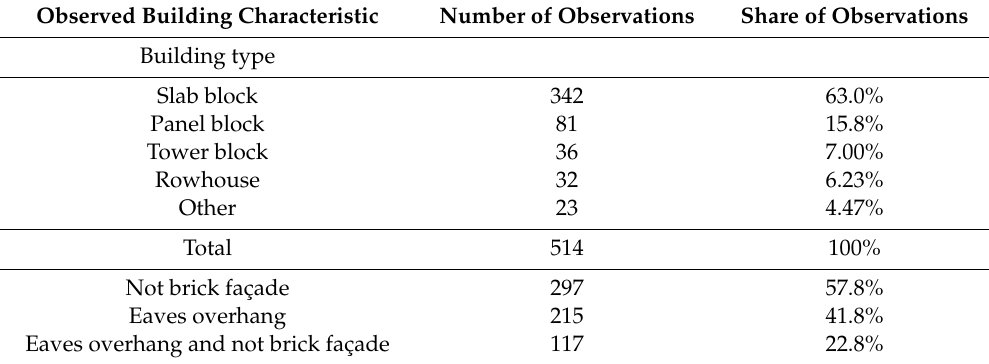
Figure 3. Example of observation in Google Street View of a building with eaves overhang and without brick façade, i.e., a building that is suitable for additional façade insulation. Table 5. A specification of the classifications of the 514 observations conducted in Google Street View.